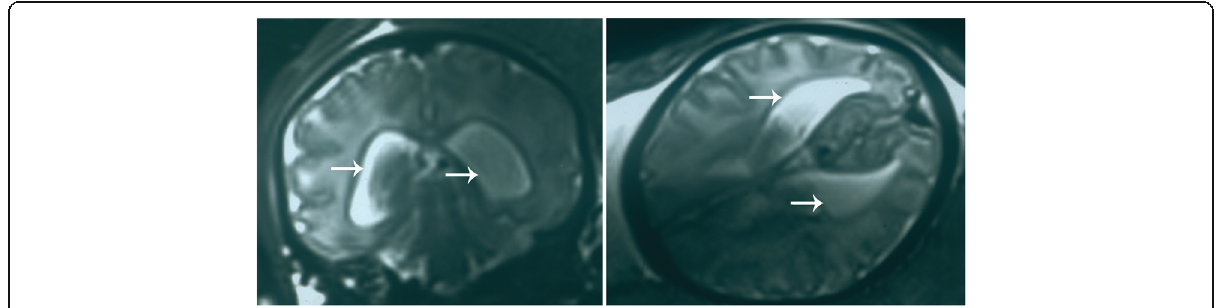
Fig. 1 Head MRI, enlarged lateral ventricles indicated congenital hydrocephalus (white arrows)